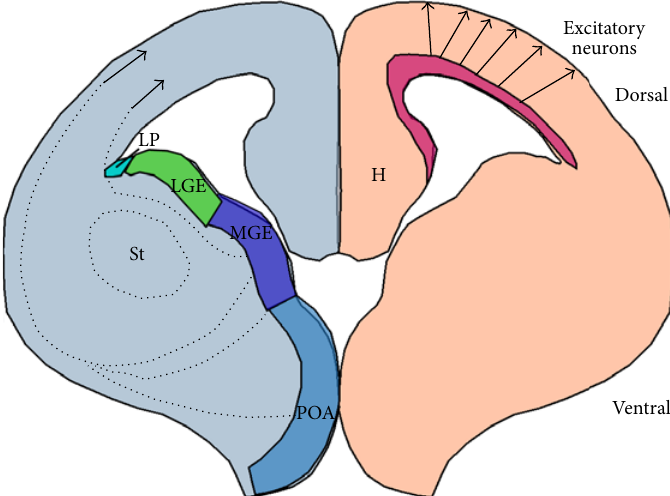
Figure 3: Schematic presentation of migratory routes of excitatory and inhibitory neurons in the developing brain (adapted from a review by Tan and Shi, WIREs Dev Biol 2012. doi: 10.1002/wdev.88). Inhibitory neurons are shown in the left side. Most of the GABAergic neurons are born in the ventral part of the telencephalon, in the subpallium, and more specifically in the medial ganglionic eminence (MGE) and the lateral ganglionic eminence (LGE), in the subpallial septum, and the embryonic preoptic area (POA), and they migrate in a tangential way to the cortex. St: striatum; LP: lateral pallium; H: